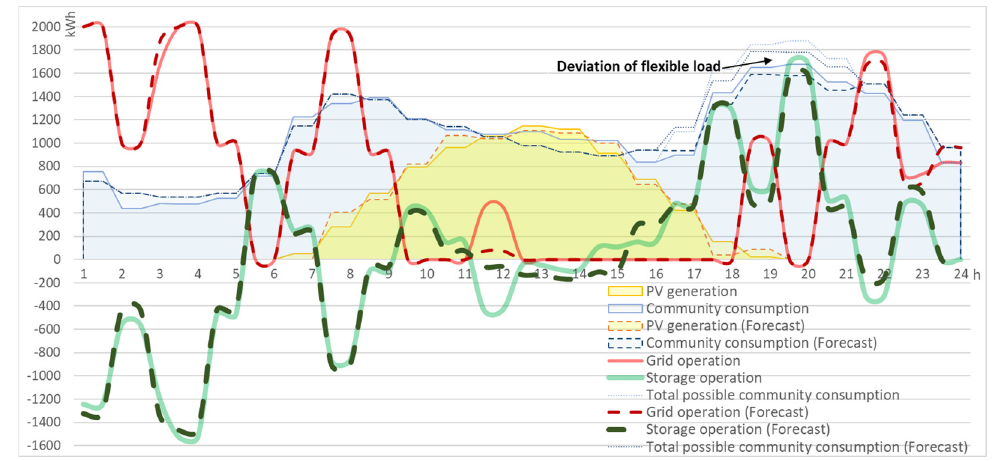
Figure 8. Twenty-four hours of OPF operation (winter).